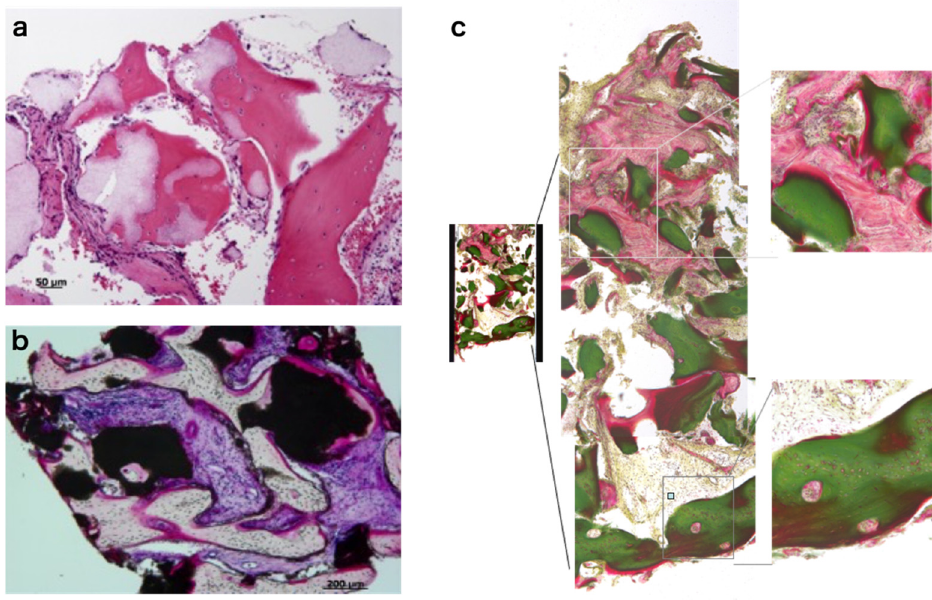
Figure 7. Histology of regenerated bone: ( a ) H&E staining, ( b ) Villanueva bone staining, and ( c ) Villanueva–Goldner staining.